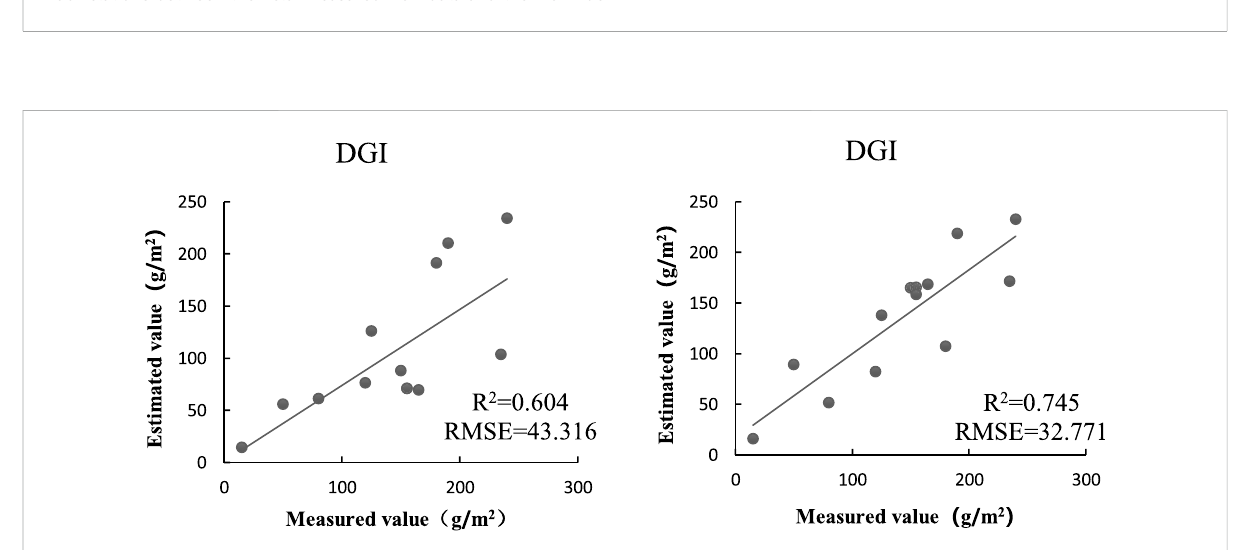
FIGURE 4 Correlations between the fi eld-measured AGB data and the estimated values based on the DGI1 and DGI2